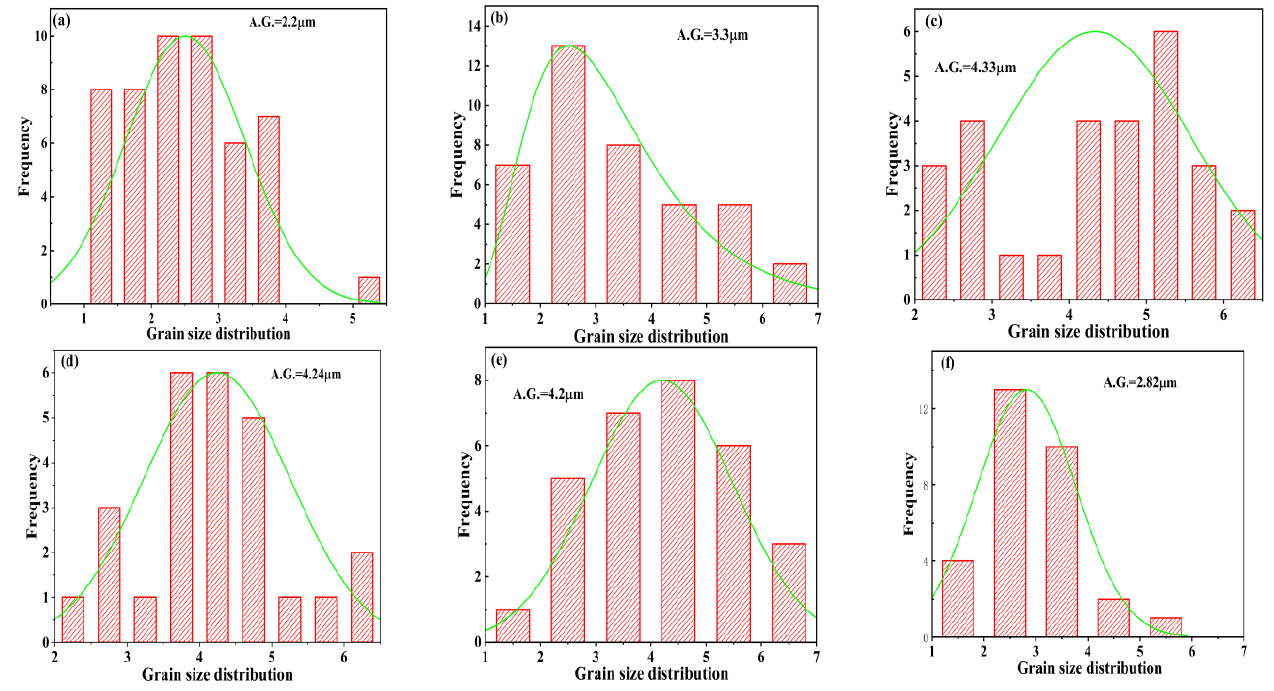
Figure 8. The average grain size of Ba 1 − x Sr x (Zn 1/3 Nb 2/3 )O 3 ceramics with ( a ) x = 0, ( b ) x = 0.1, ( c ) x = 0.2, ( d ) x = 0.4, ( e ) x = 0.6, and ( f ) x = 0.8.